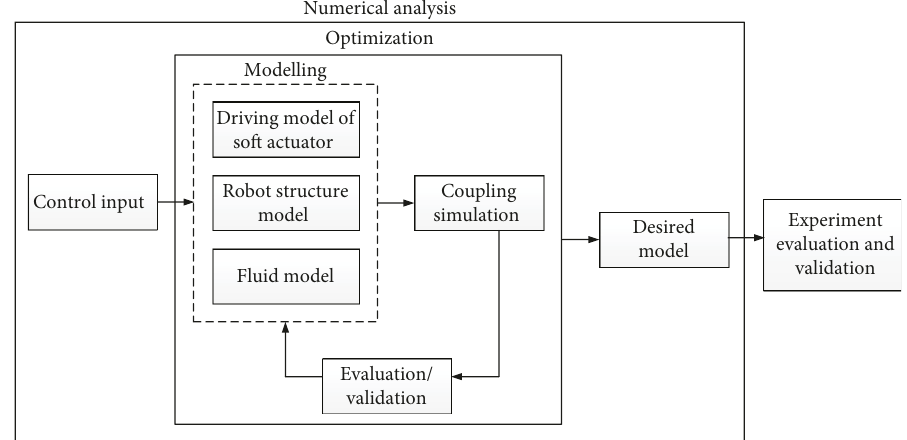
Figure 3: Design procedure of the soft robotic fi